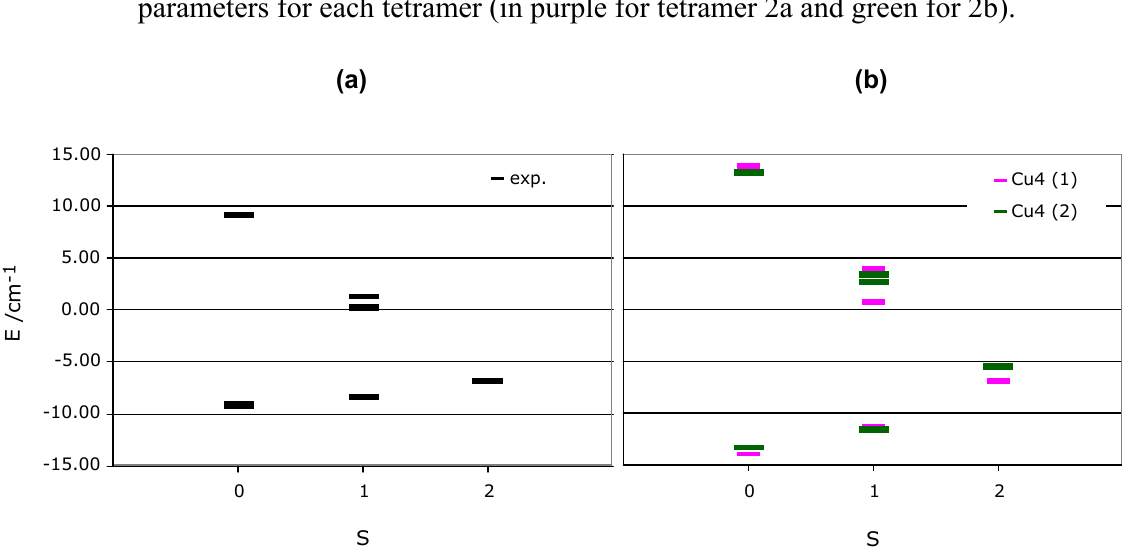
fitted ij computed AB